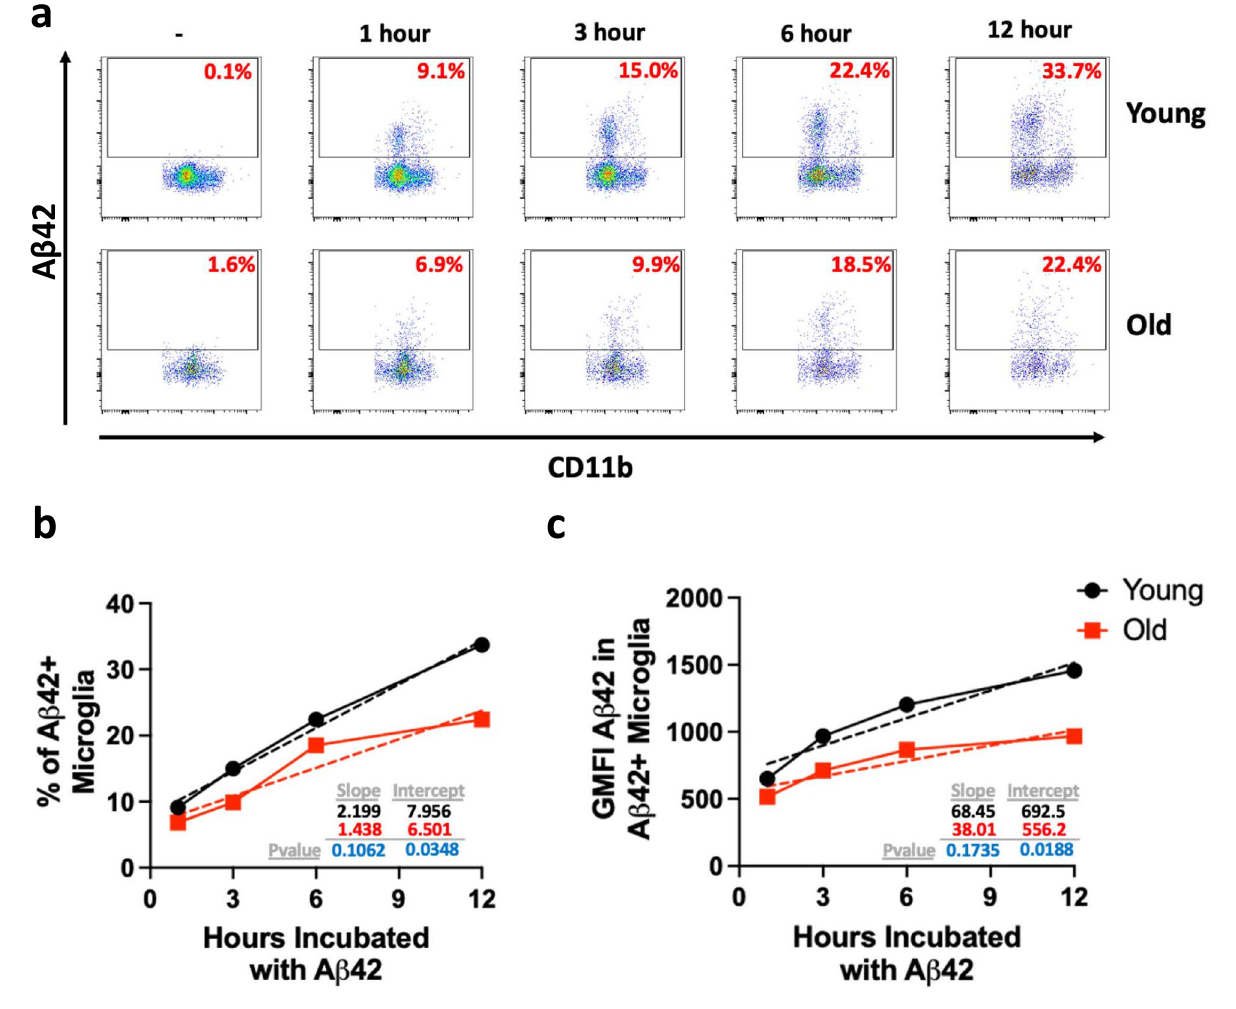
Figure 2. Aged microglia have less uptake capacity of Aβ overtime than their younger counterparts. Microglia from 3 young (2 months) or old (22 months) female mice were isolated, combined with their age-matched counterparts, and divided into 5 time points where they were incubated with 2.5 μM of Aβ42 for 1, 3, 6, and 12 h. Microglia were analyzed via flow cytometry to measure phagocytosis. ( a ) Representative flow plots of 1 replicate showing uptake of Aβ42 by microglia over time. ( b ) % of microglia that are Aβ42 positive over time. Dashed lines indicate line of best fit. ( c ) Geometric mean of Aβ42 in Aβ42 + microglia. Dashed lines indicate line of best fit. Simple linear regression was used to determine differences between the lines of best